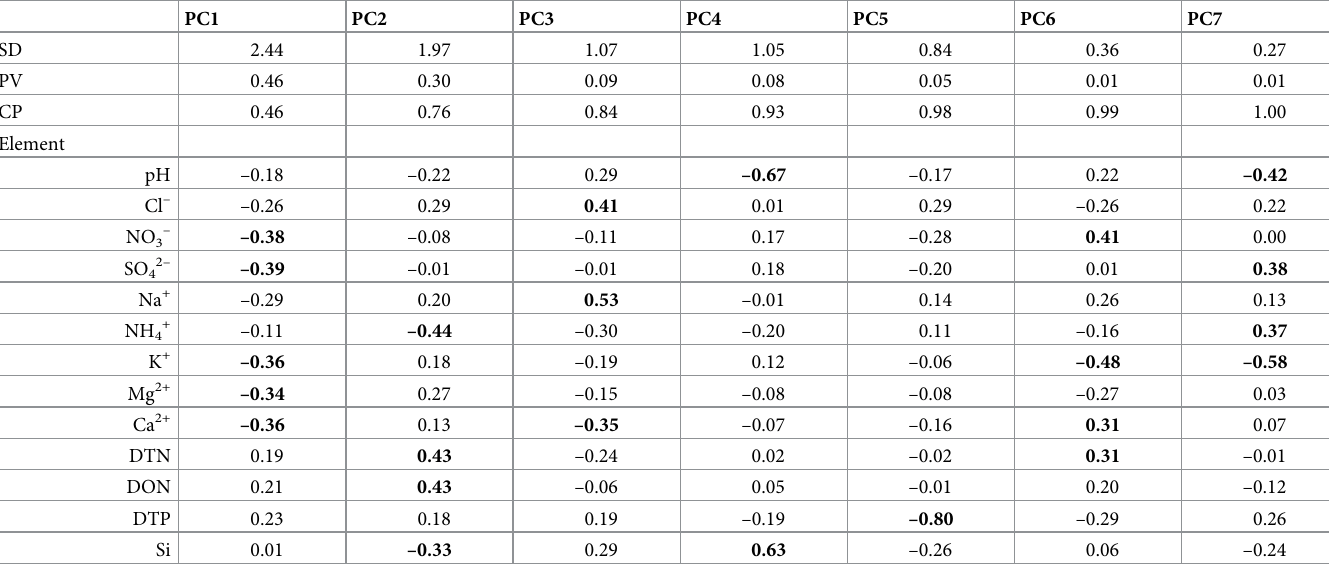
Table 2. Summary of habitat characteristics based on concentrations of soil water chemistry using